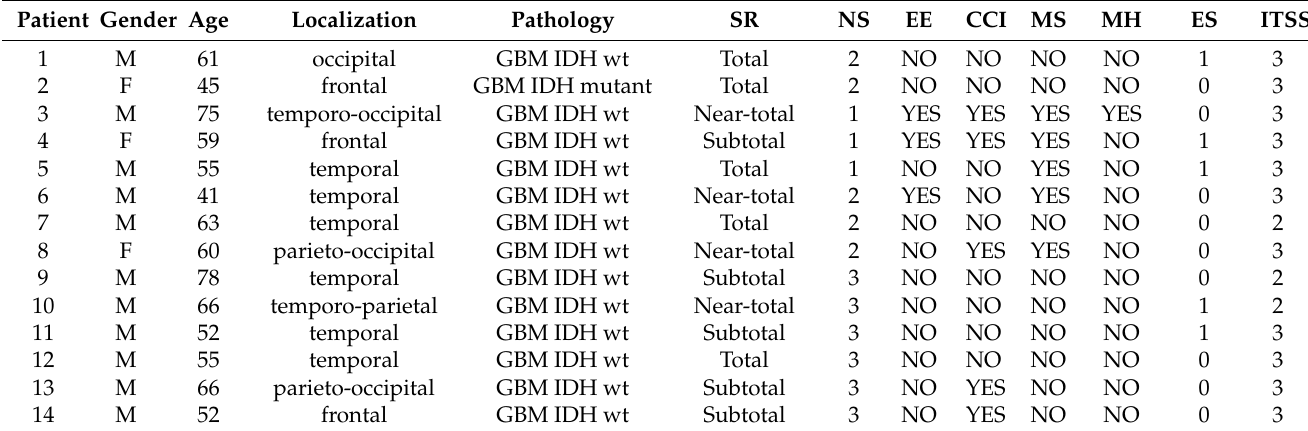
Table 1. Characteristics of 14 WHO-IV grade glioma